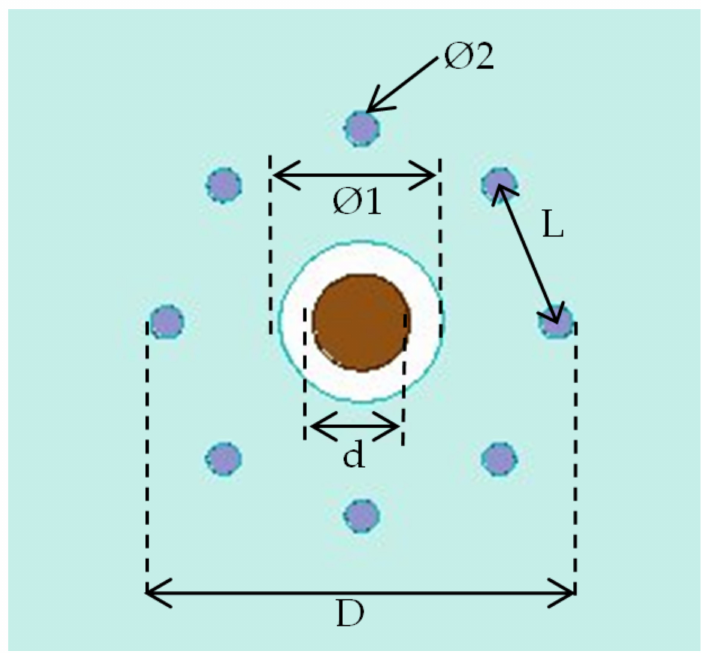
Figure 8. Mixed dielectric materials coaxial